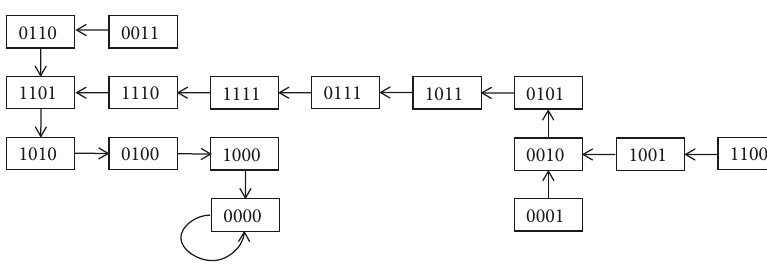
Figure 9: State diagram of NFSR with the feedback functions 𝑓 󸀠󸀠 in Example